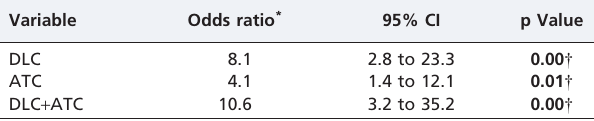
Table 2 - Multivariate analysis of auricular creases adjusted for potential